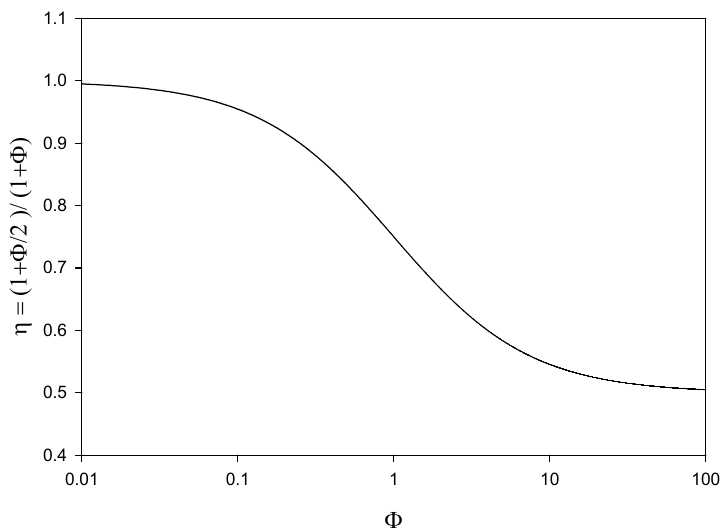
Figure A1. Plot of Equation (A38) illustrating the variation of the efficiency factor η with Φ